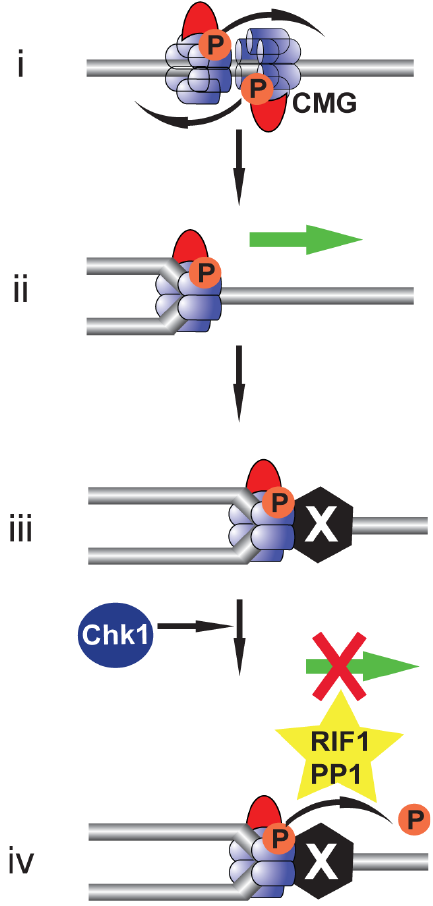
Figure 3. Rif1:PP1-mediated CMG dephosphorylation in response to checkpoint activation